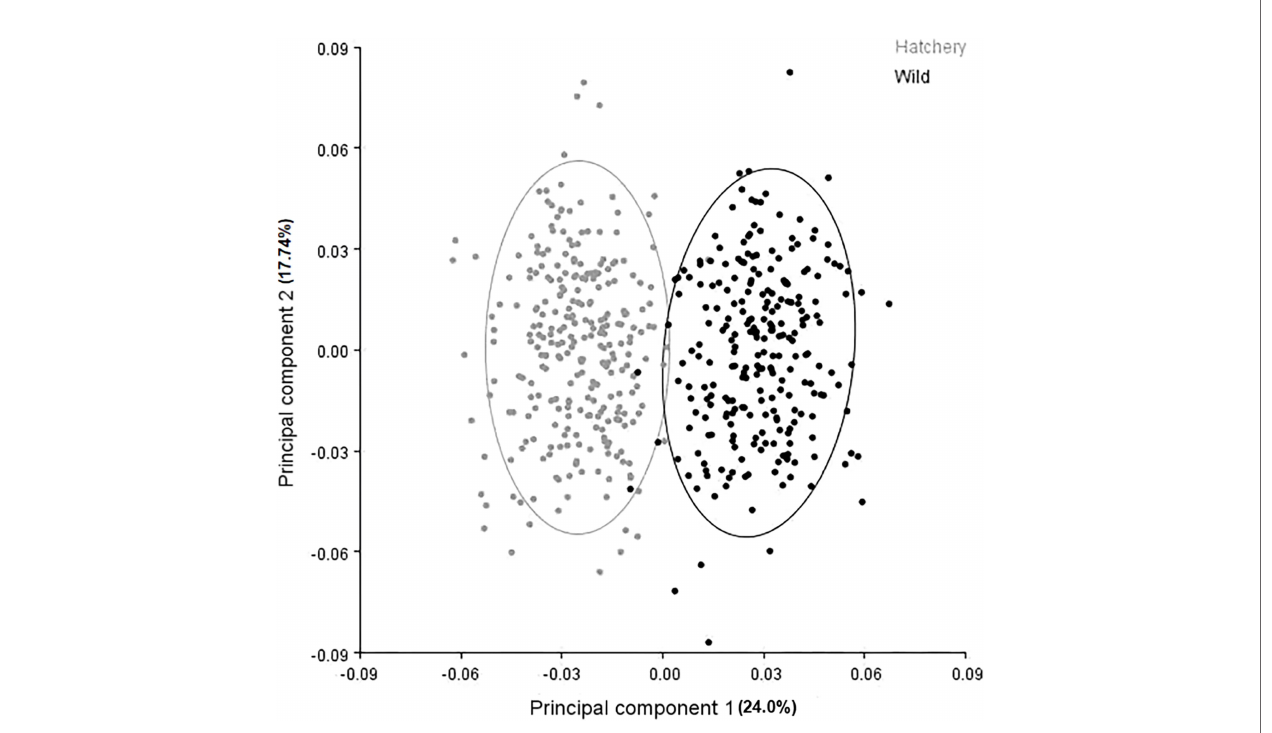
FIGURE 6 | Principal component biplot illustrating overall body shape variation for groups of wild (black dots) and hatchery-reared (grey dots) marbled rock fi sh.